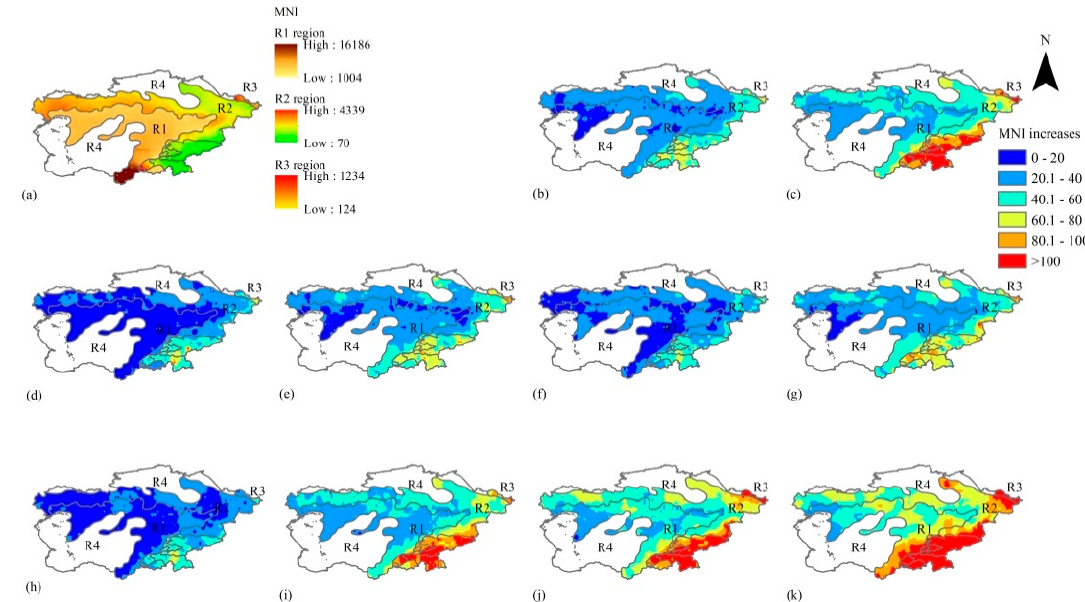
Figure 9. Distribution of MNI in the fire season for each vegetation zone. ( a ) Baseline; ( b ) the mean MNI increase in the 2030s; ( d ), ( e ), ( f ), and ( g ) are MNI increases under the RCP2.6, RCP4.5, RCP6.0, and RCP8.5 scenarios in the 2030s, respectively; ( c1 ) the mean MNI increase in the 2080s; and ( h ), ( i ), ( j ), and ( k ) are MNI increases under the RCP2.6, RCP4.5, RCP6.0, and RCP8.5 scenarios in the 2080s, respectively.